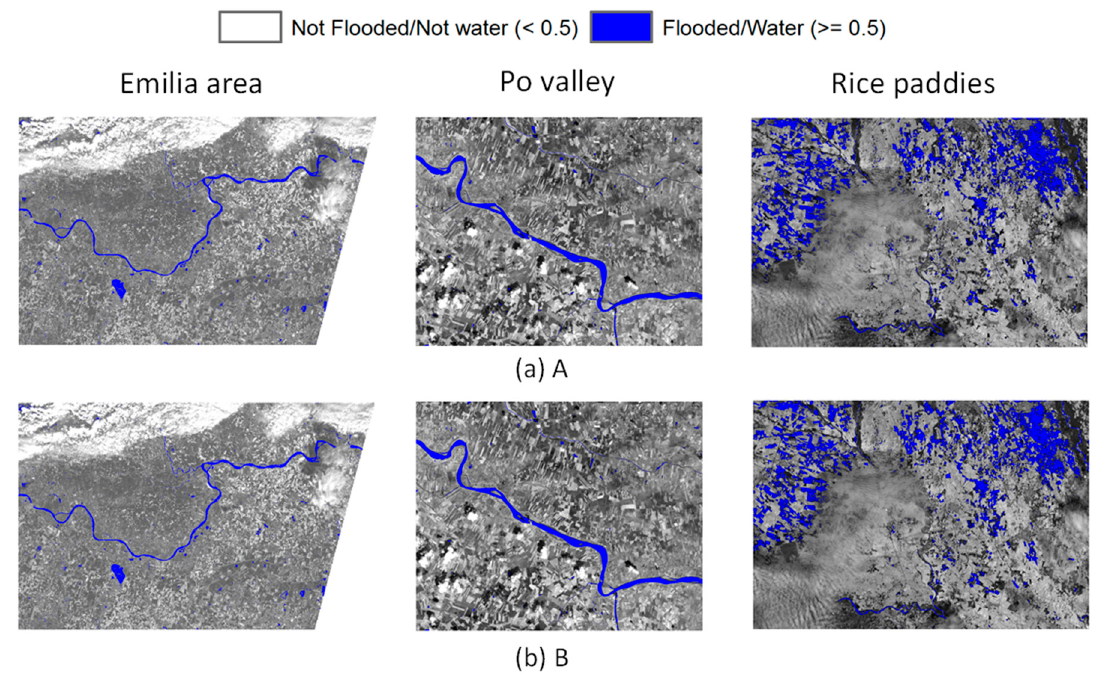
Figure 10. ESI maps in the three ROIs obtained by using interpretations of the two experts A and B and by averaging the weighting vectors of the OWA operators learned on 10 runs of the algorithm in the atypical settings. Values considered as standing water are in blue and are obtained by a threshold on ESI > 0.5.